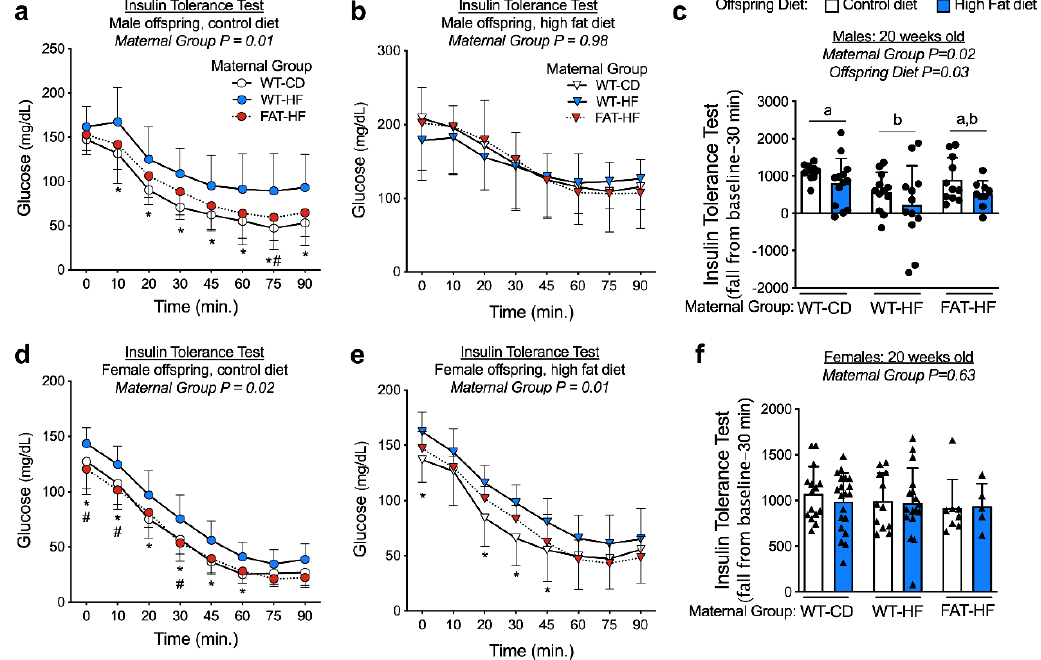
Figure 4. Maternal fat-1 transgene partially protects o ff spring from insulin resistance. Blood glucose levels were measured following bolus insulin injection (insulin tolerance test) in o ff spring of WT dams fed a control diet (WT-CD), or o ff spring of WT or fat-1 hemizygous dams fed a high-fat diet (WT-HF and FAT-HF, respectively) throughout pregnancy and lactation. All o ff spring were WT and were weaned to control or high-fat diet for male ( a – c ) or female ( d – f ) o ff spring. For c, f , data are the area fall from baseline over 30 minutes with baseline represented as fasting glucose levels. For males, n ≥ 9 per group. For females, n ≥ 5 per group. All data are presented as mean ± SD. * p < 0.05 for di ff erence between WT-CD and WT-HF. Di ff erent letters above bars denote statistically significant di ff erences between those bars at p < 0.05 significance level.